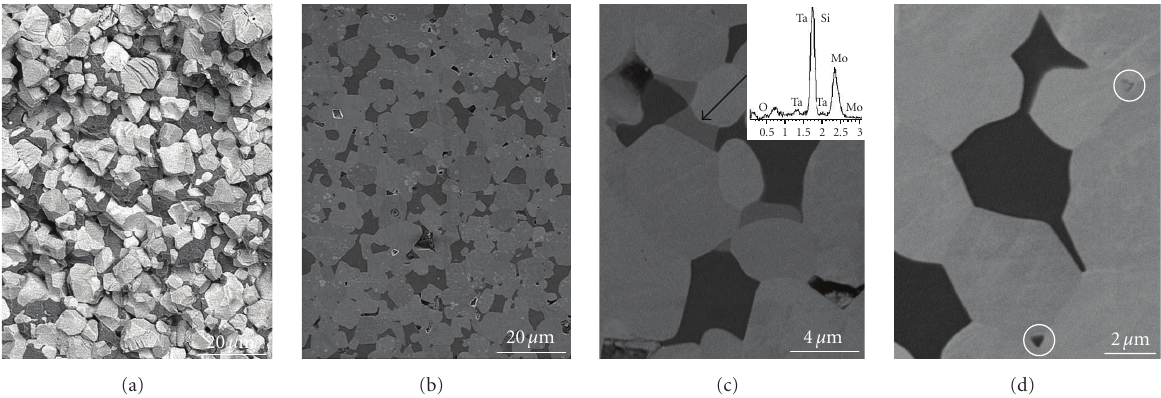
Figure 8: (a) Fractured and (b)–(d) polished section of TC20. The bright phase is TaC, the dark phase is MoSi 2 , and the arrow in (c) indicates the reaction product formed during sintering, identified as (Ta,Mo) 5 Si 3 . (d) MoSi 2 phase squeezed among the matrix and, circled, the triple point junctions constituted by (Ta,Mo) 5 Si 2 C.